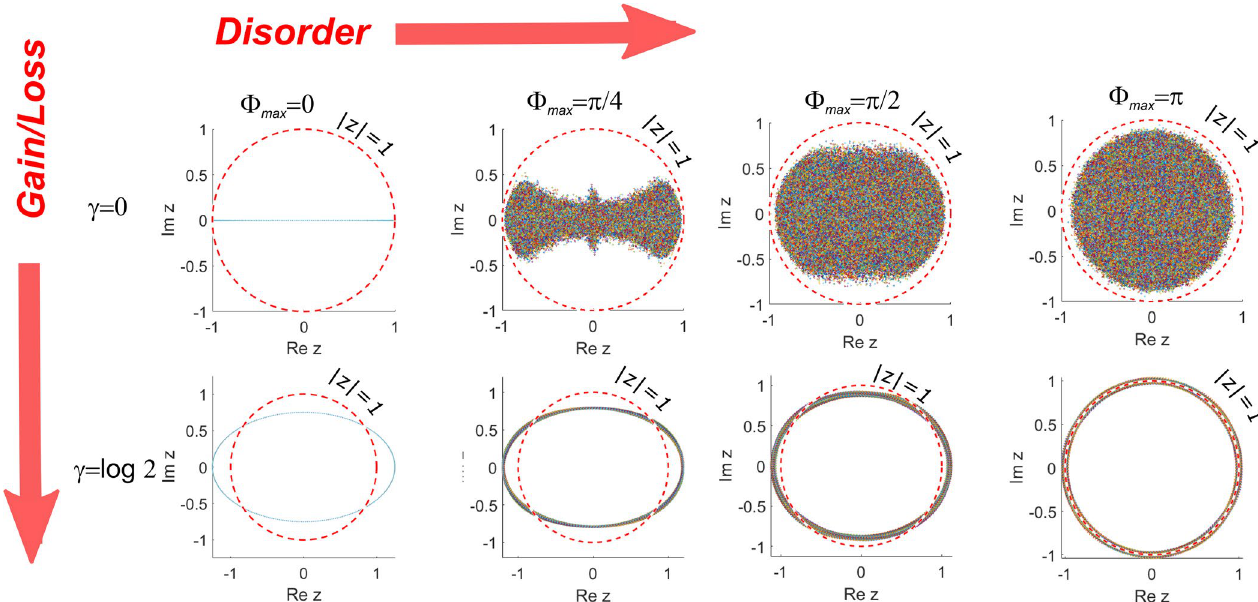
Figure 2. The support of eigenvalues of system (2) for the increasing values of disorder (left to right) for pure random clock model (top) and GHN (bottom). The stability margin | z | = 1 is shown by dashed red